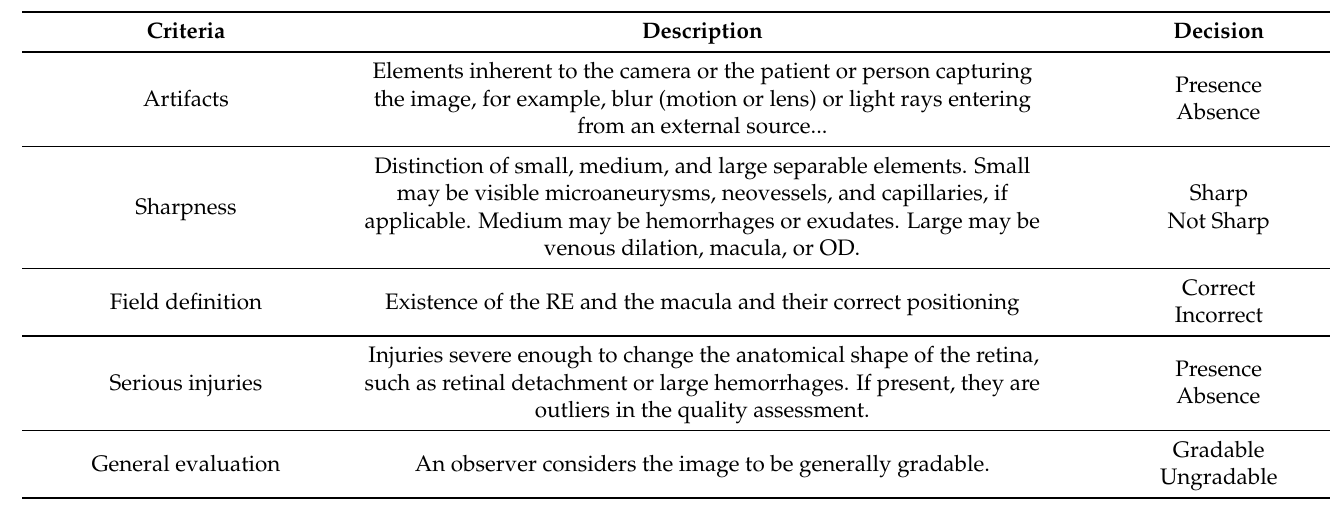
Table 1. Human visual perception